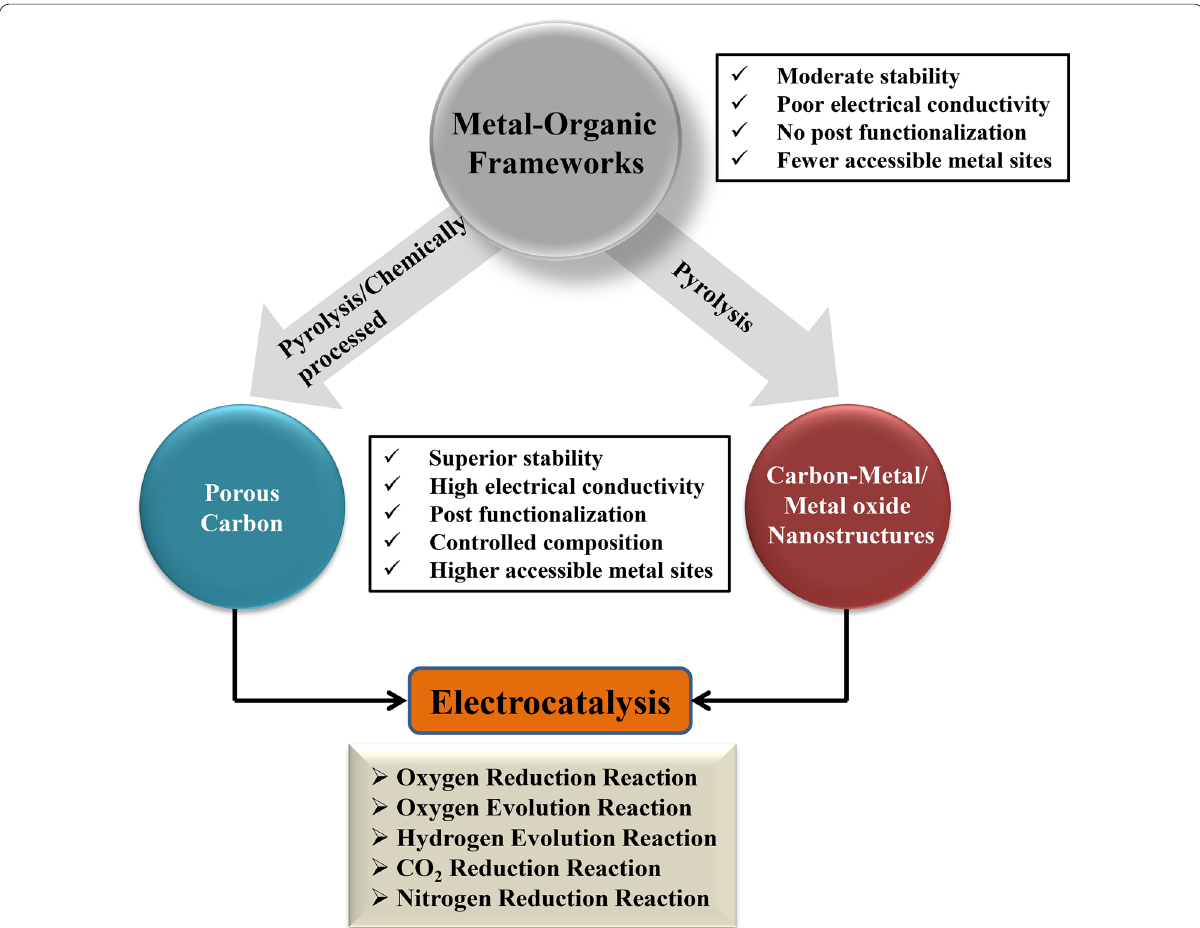
Fig. 2 Summary of the different routes for the synthesis of MOF-derived porous graphitic carbon-rich materials, alongside their chemical, electrical and catalytic properties and application in